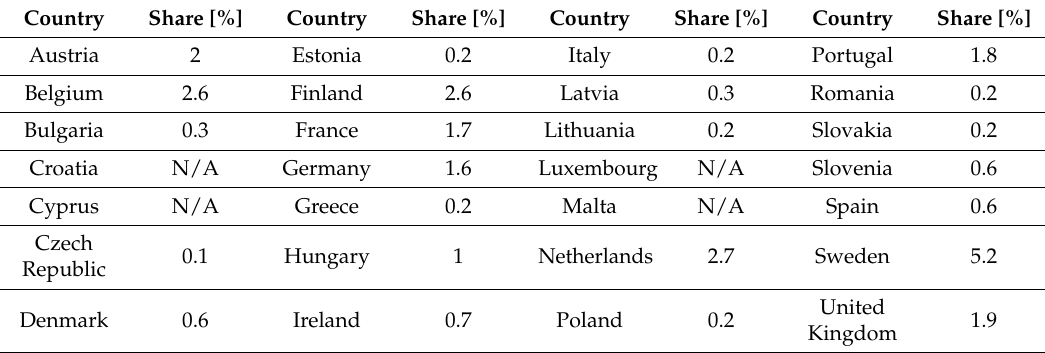
Table 1. Market share of sold Electrically-Chargeable Vehicles in the EU